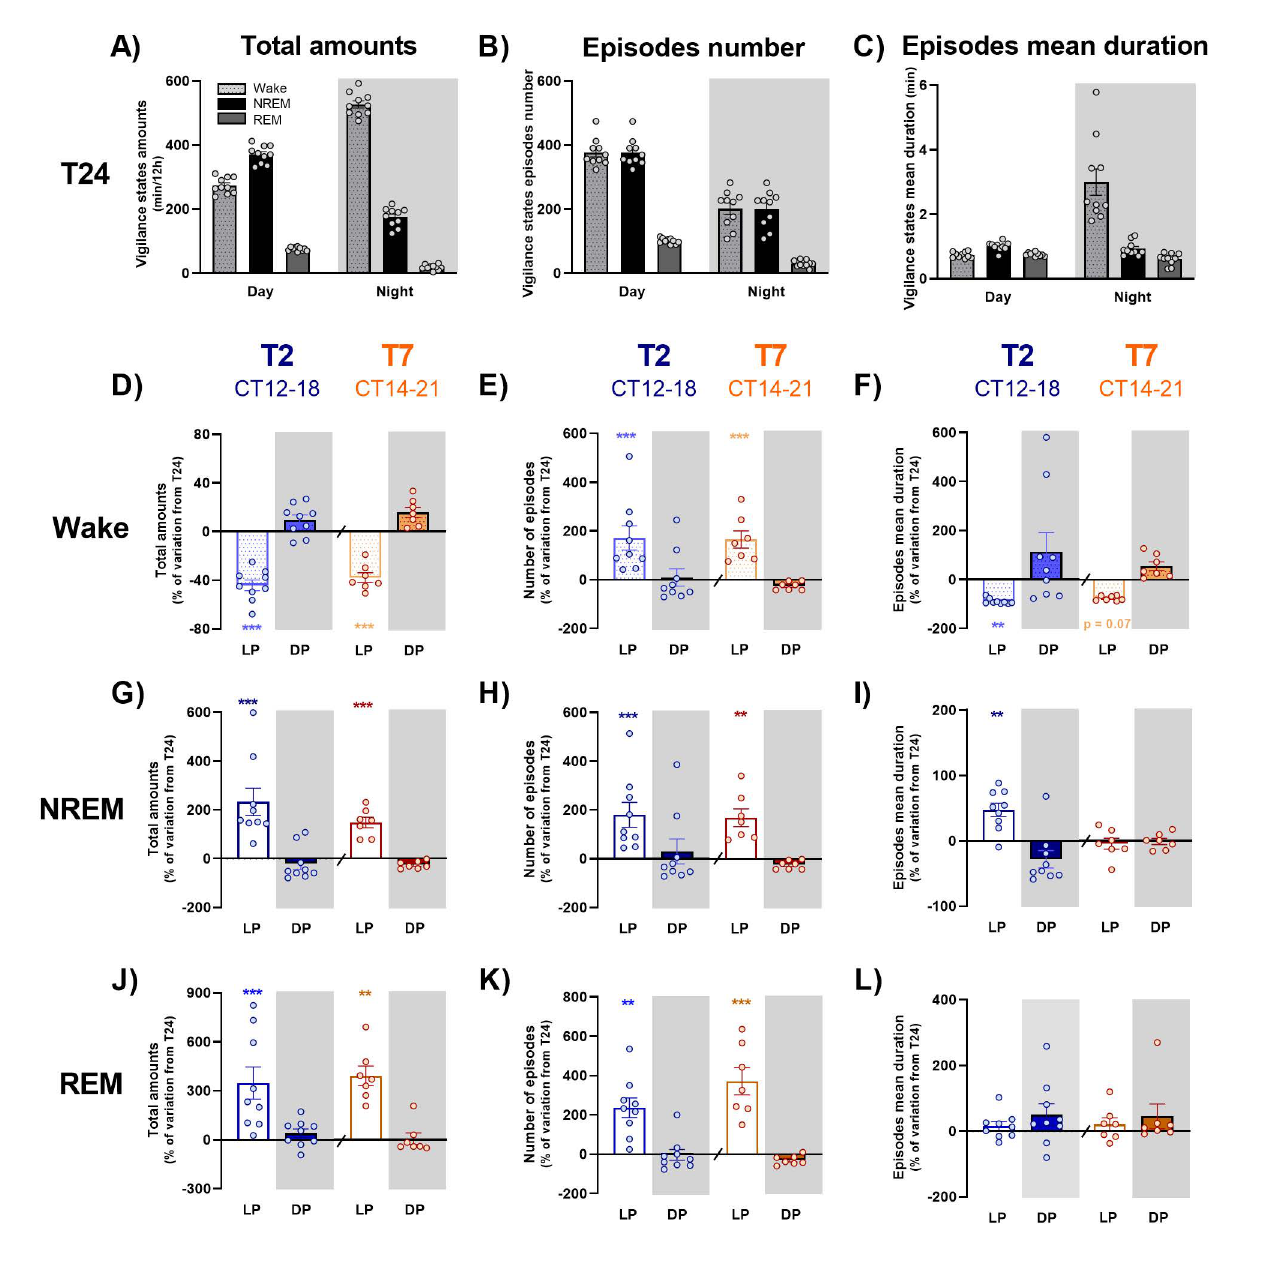
Figure 2. Influence of light and dark pulses on wake, NREM and REM sleep organization under T2 and T7, compared to T24 cycle. Wake (pale hatched bars), NREM (dark bars) and REM (pale bars) sleep total amounts ( A ), number of episodes ( B ) and episodes’ mean duration ( C ) under day and night of T24 cycle. The percentage of variation from T24 cycle for total amounts of wake ( D ), NREM ( G ) and REM ( J ) sleep, number of episodes of wake ( E ), NREM ( H ) and REM ( K ) sleep, and for episodes mean duration of wake ( F ), NREM ( I ) and REM ( L ) sleep during light (empty bars) and dark (filled bars) pulses averaged for CT12-18 under T2 (blue) and CT14-21 under T7 cycle (orange). Histograms represent means ± SEM, circles represent individual values. Grey areas delineate dark exposures. **, p < 0.01, ***, p < 0.001: difference between results obtained under T2/T7 and T24 cycle. LP: light pulse; DP: dark pulse. T24: n = 10; T2: n = 9; T7: n =